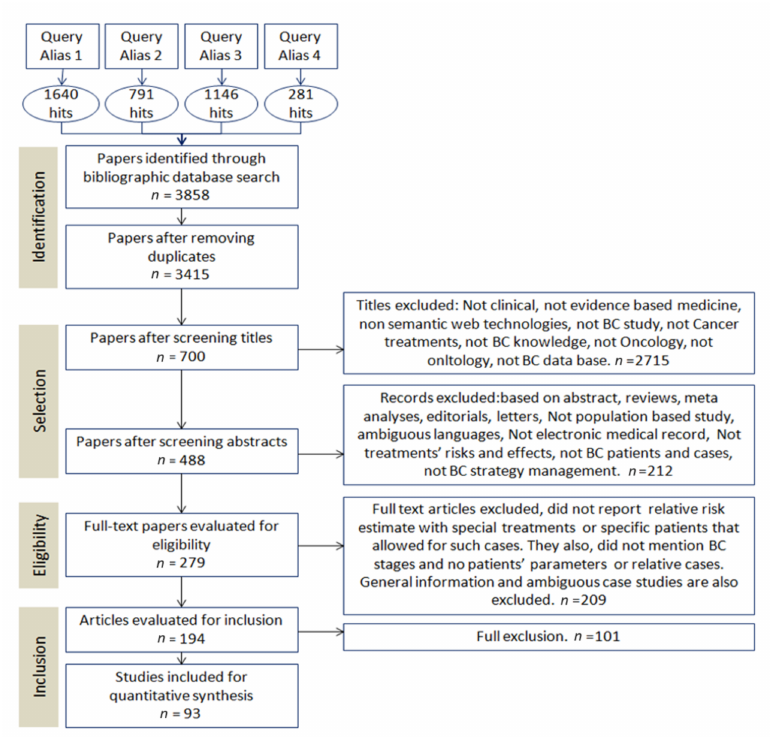
Figure 1. Flow diagram for BC data collection and study